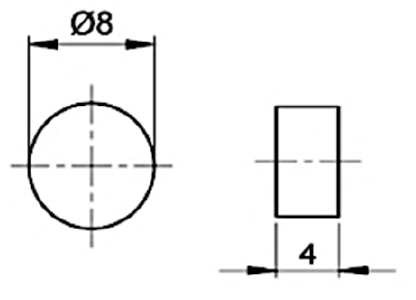
Figure 2. Dimensions of the cylindrical compression sample.